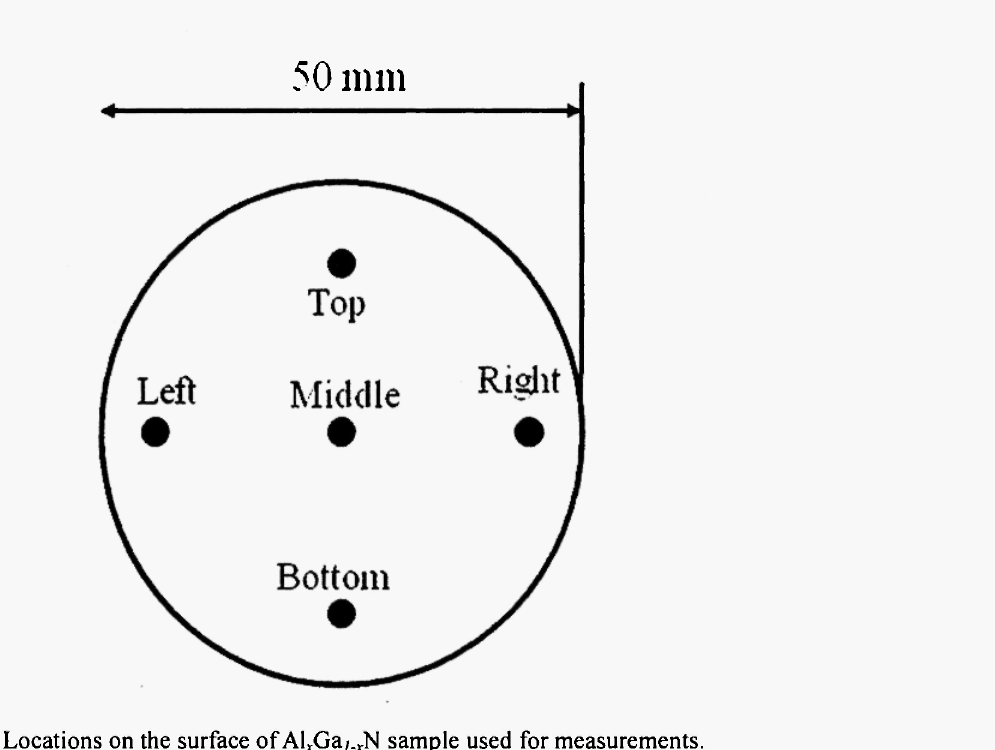
Fig. 1: Locations on the surface of Al v Ga/_ x N sample used for